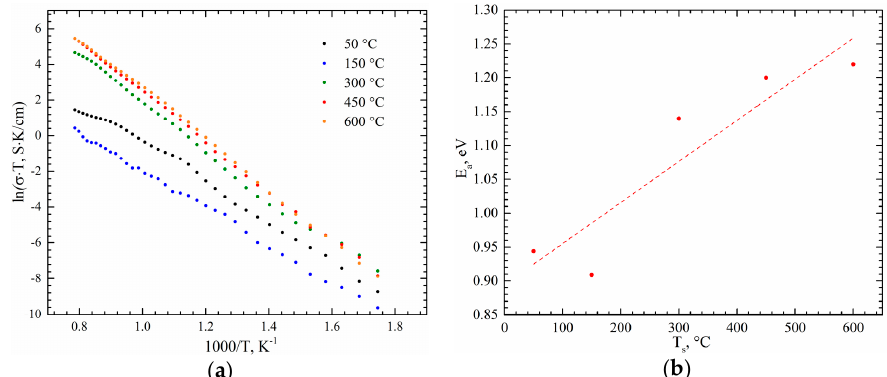
Figure 6. ( a ) Arrhenius plots of ScSZAl thin films deposited on Al 2 O 3 substrates using a 0.4 nm/s deposition rate and ( b ) vacancy activation energy dependence on the substrate temperature of ScSZAl